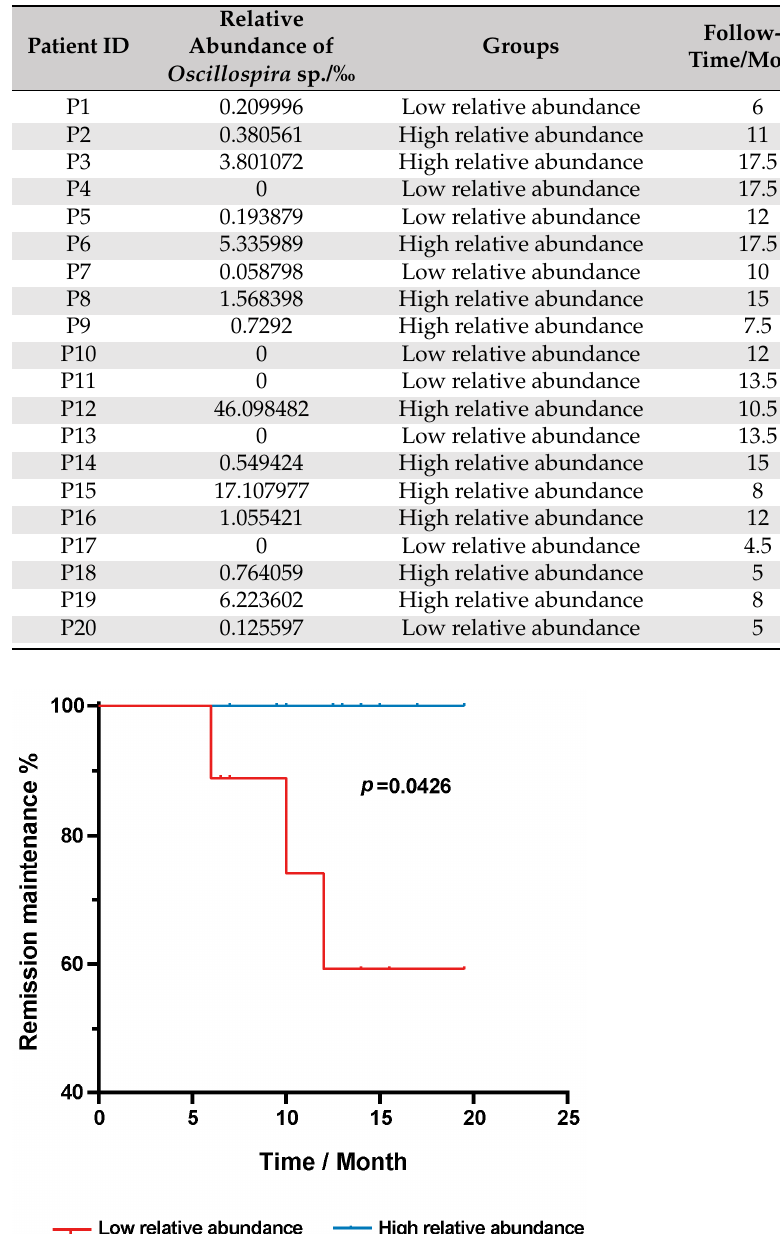
Table 2. Relative abundance of Oscillospira sp. in residual intestine segment and follow-up.